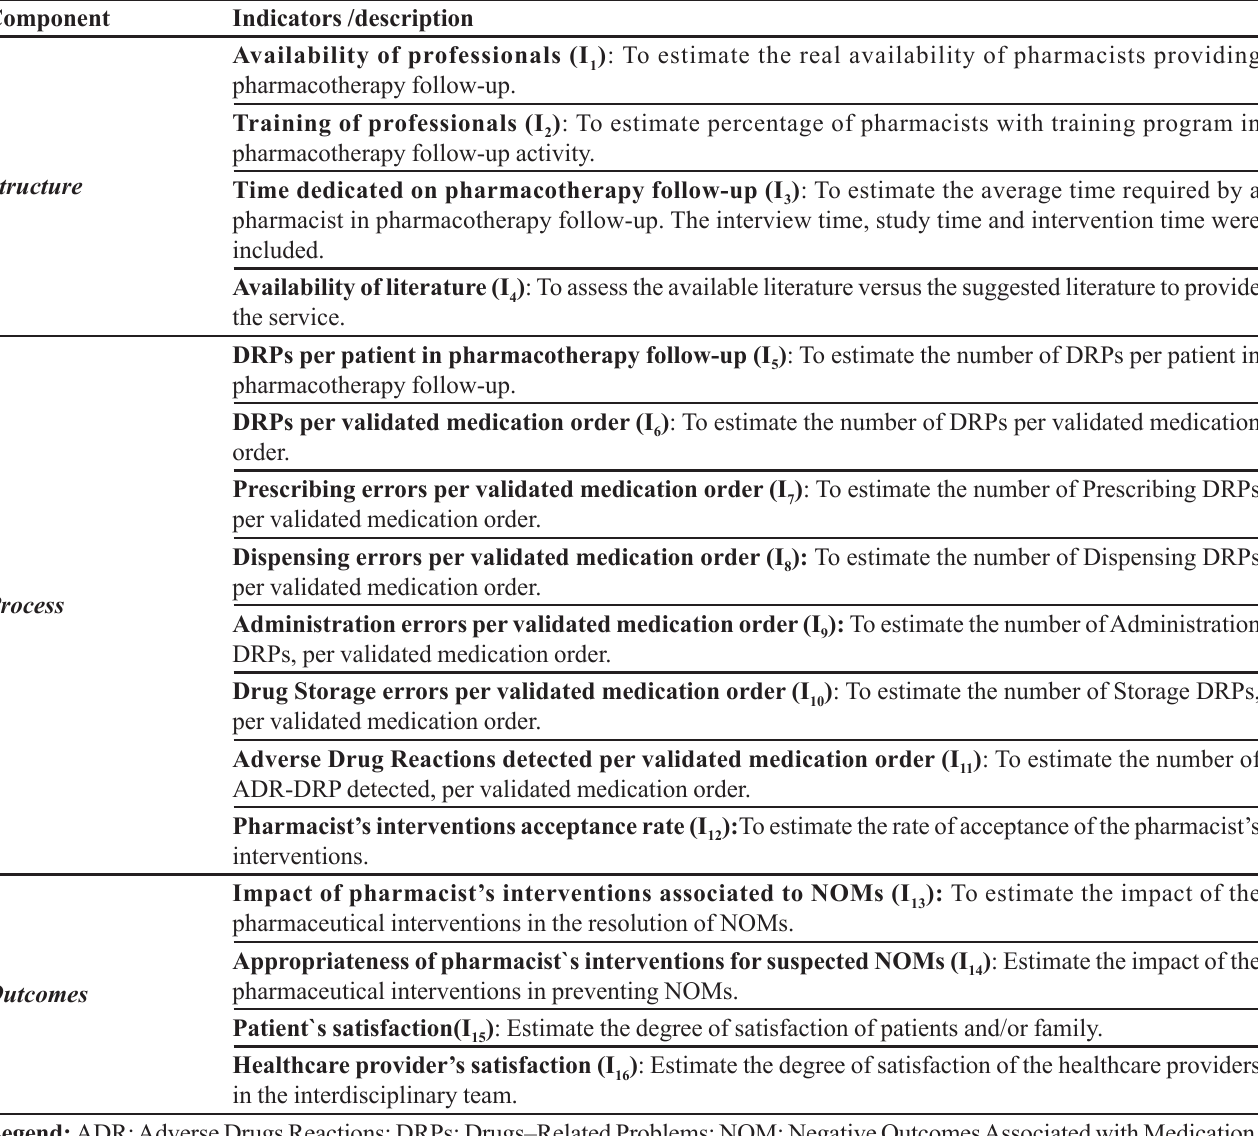
TABLE III - Quality assurance indicators for Pharmacotherapy Follow-up service Component Indicators /description